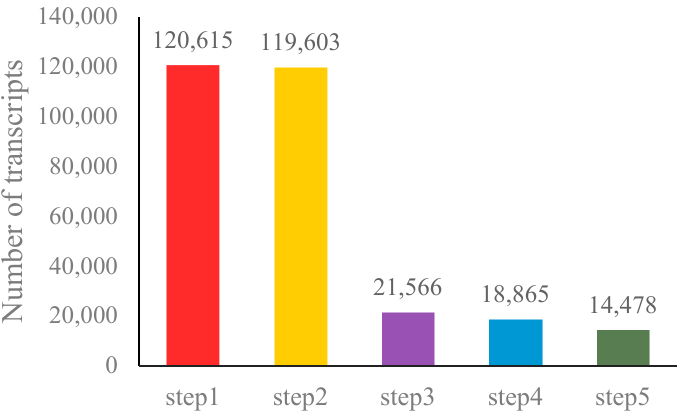
Figure 1. Statistics of candidate long noncoding RNAs (lncRNAs). Five filter processes were used to identify lncRNAs. Step1 filtered out the low expression transcripts. Step2 filtered transcripts with length <200 nucleotides. Step3 filtered out the transcripts that contain exon region. Step4 selected transcripts with FPKM (fragments per kilobase of exon per million fragments mapped) ≥ 0.5. In Step5 we selected for coding potential, and finally 14,478 lncRNAs remained.